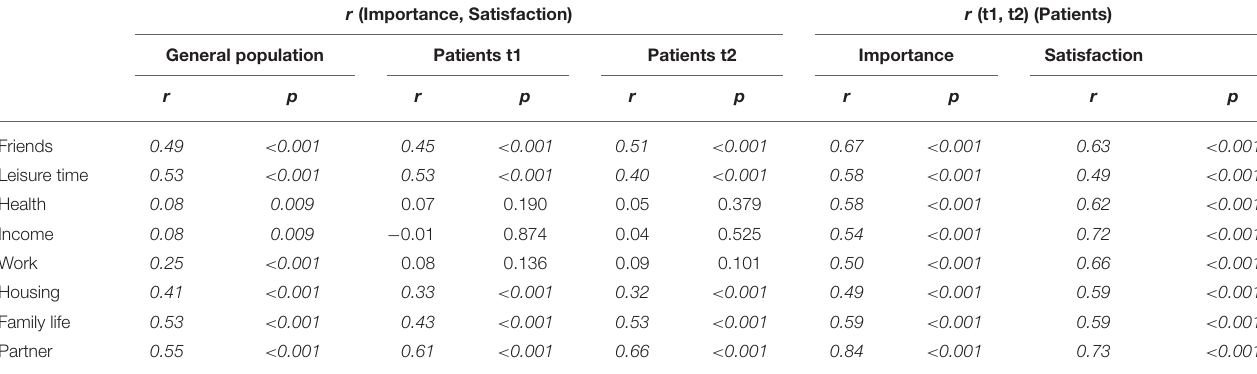
TABLE 3 | Relationship between importance and satisfaction;